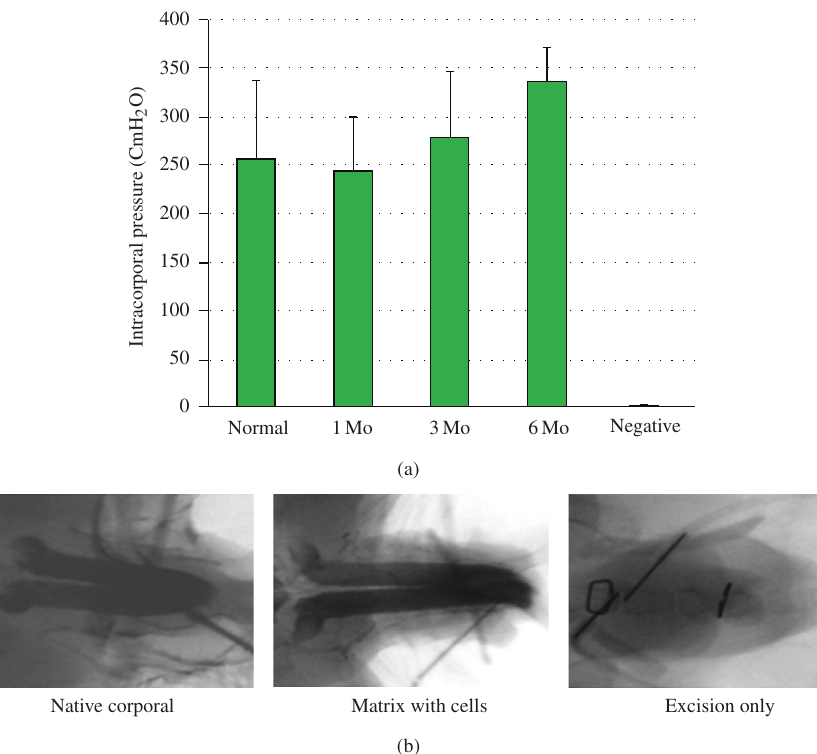
FIGURE 2: (a) Cavernosometry shows that all rabbits implanted with the bioengineered corpora after com- plete pendular penile corporal excision had sufficient intracorporal pressure (ICP) to attain erection. The levels of ICP were comparable to native corpora. (b) Cavernosography shows a homogenous appearance of corpora in the bioengineered group, similar to the native corpora, and multiple filling defects in the negative control